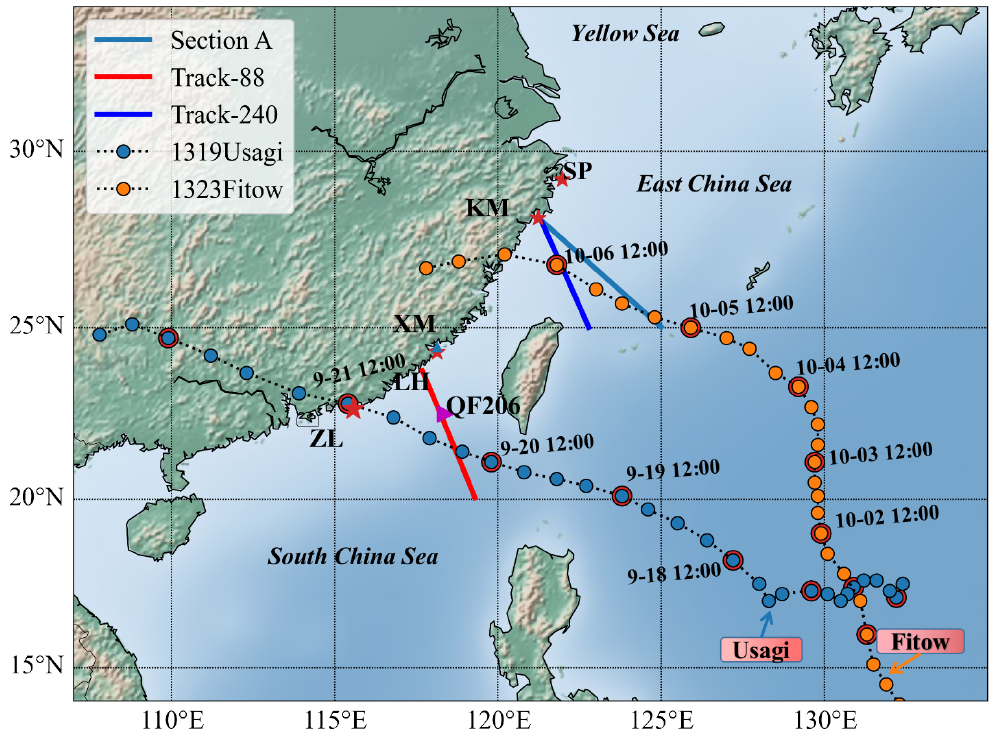
Figure 1. Geographical distribution of satellite ground tracks of Jason-2 track-88 (red line) and track-240 (blue line), coastal tide gauges (star), QF206 buoy location (magenta triangle), and the tracks of Typhoons 1319Usagi and 1323Fitow. ZL: Zhelang, LH: Longhai, XM: Xiamen, KM: Kanmen, SP: